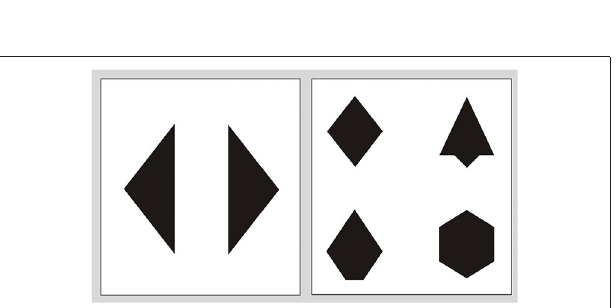
FIGURE 1 | 24-piece jigsaw puzzle presented to parent–child dyads in the lab.